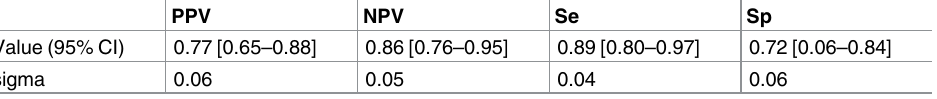
Table 4. Evaluation of the clinical significance of the grouped lactate-GABA-butyrate considered as